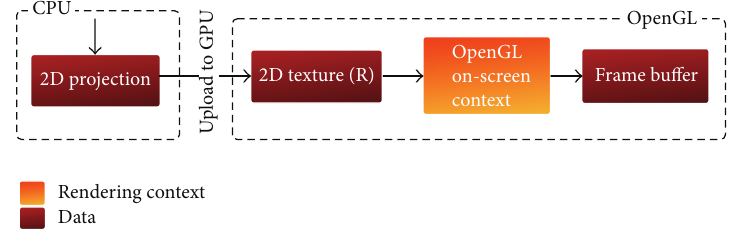
Figure 4: Communication between the computational context and OpenGL on-screen